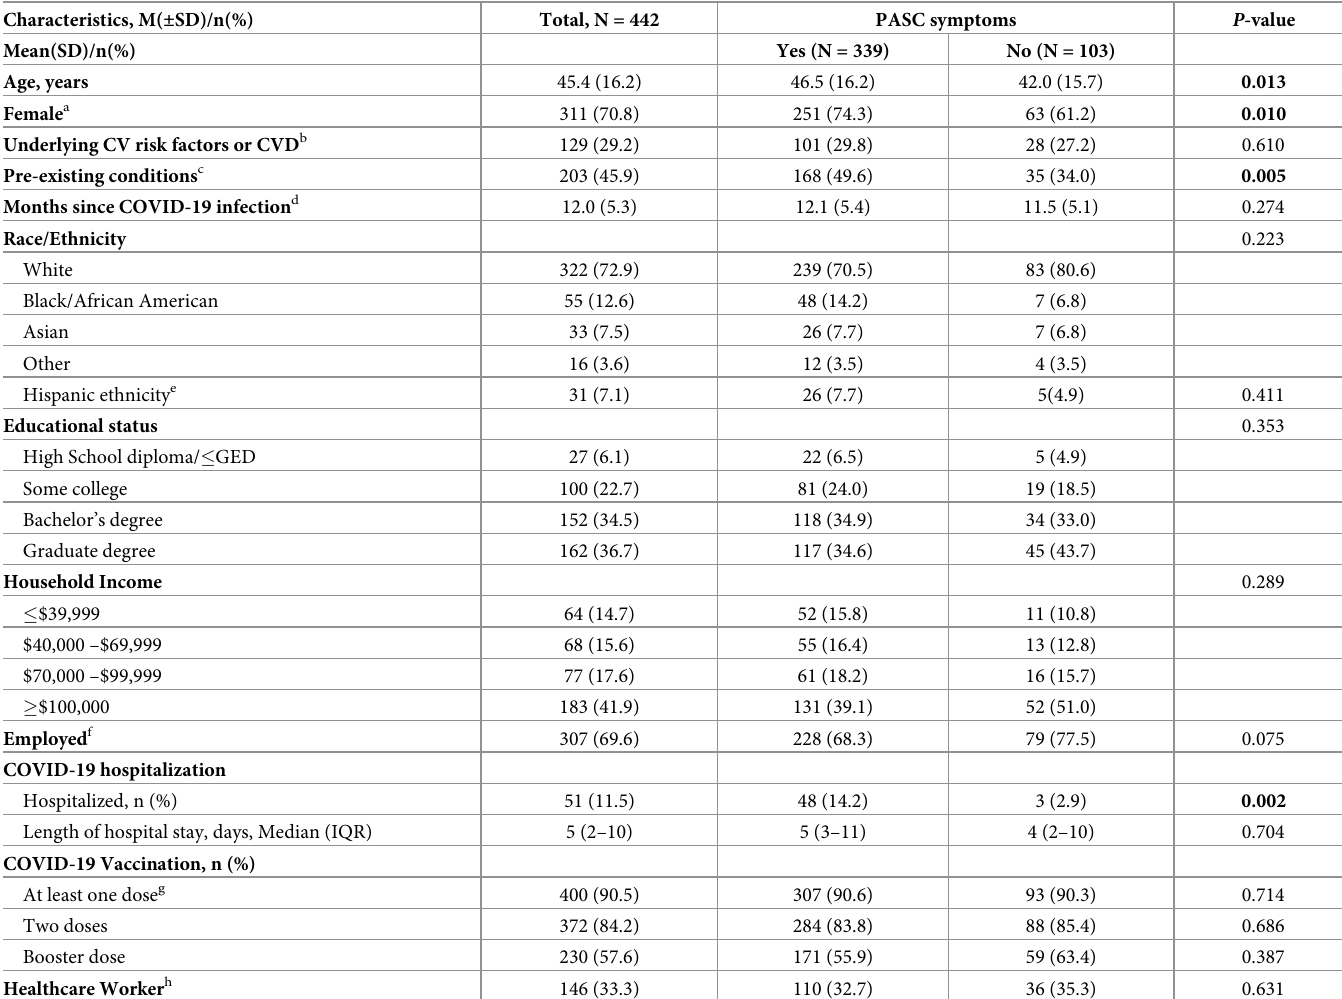
Table 1. Sociodemographic characteristics stratified by report of PASC symptoms (N = 442). Characteristics, M( ±